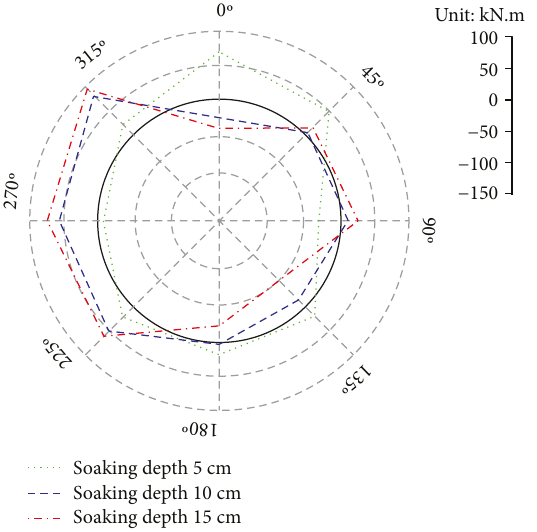
Figure 13: Bending moment of half-range soaking in fi nal